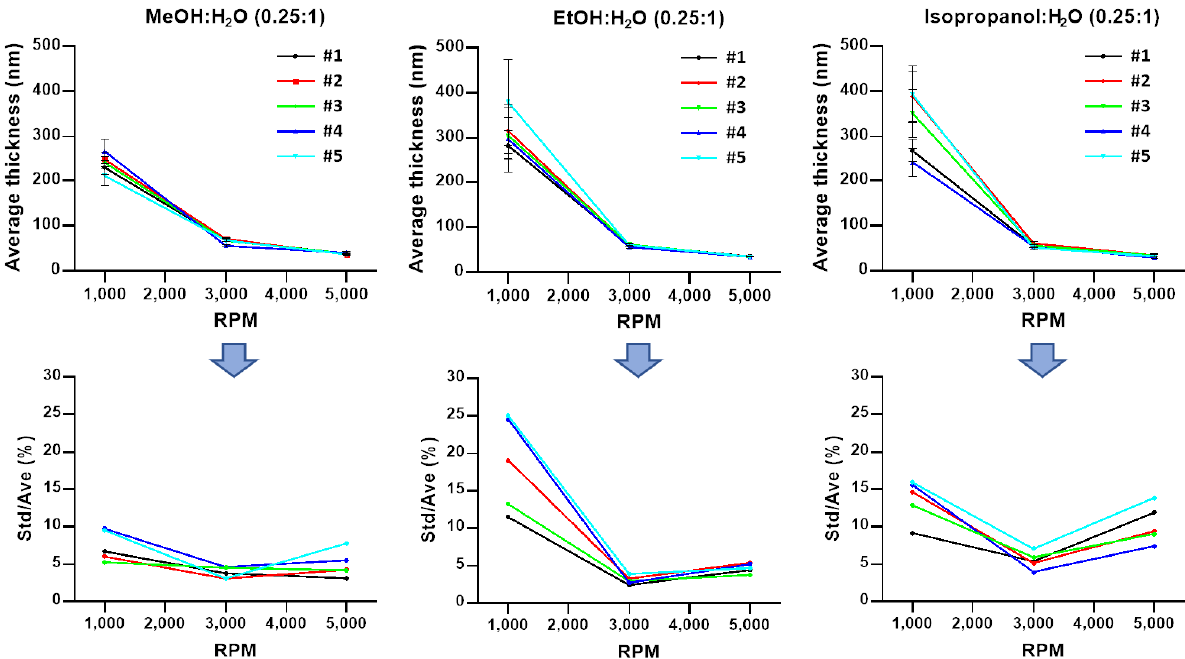
Figure 3. A total of 5 data sets of average thickness and standard deviation from 5 × 5 measurements of 0.25:1 MeOH/H 2 O, 0.25:1 EtOH/H 2 O, and 0.25:1 isopropanol/H 2 O DNA solution films. An amount of 2 mL of aqueous DNA at 8 mg/mL (0.8 wt.%) diluted with 0.5 mL of methanol, ethanol, and isopropanol, respectively.